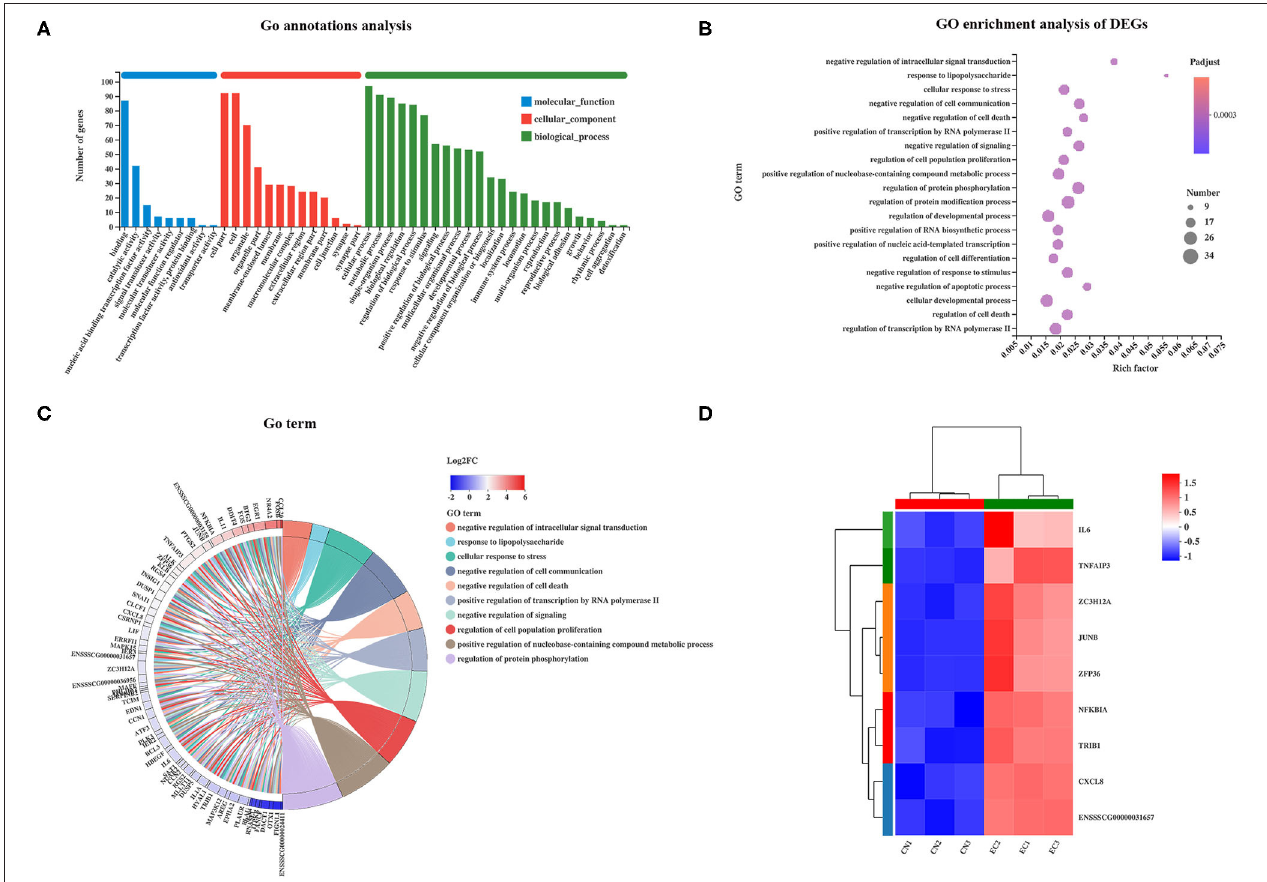
FIGURE 5 | GO enrichment analysis of DEGs. (A) GO functional annotation of DEGs. (B) GO enrichment analysis of DEGs. Enriched bubble chart showing enrichment of GO functions. X-axis represented enrichment ratio, and Y-axis represented top 20 GO terms. Number: Bubble size represented number of genes annotated to a KEGG Pathway. Padjust: color indicated enriched adjusted p -value. (C) GOChord plot of top 10 ranked GO terms. Chords indicated a detailed relationship between expression levels of DEGs (left semicircle perimeter) and their enriched GO terms (right semicircle perimeter). Genes are linked to their annotated terms via colored ribbons. (D) Heatmap of DEGs enriched in GO term “the response to LPS” showing the expression profile.